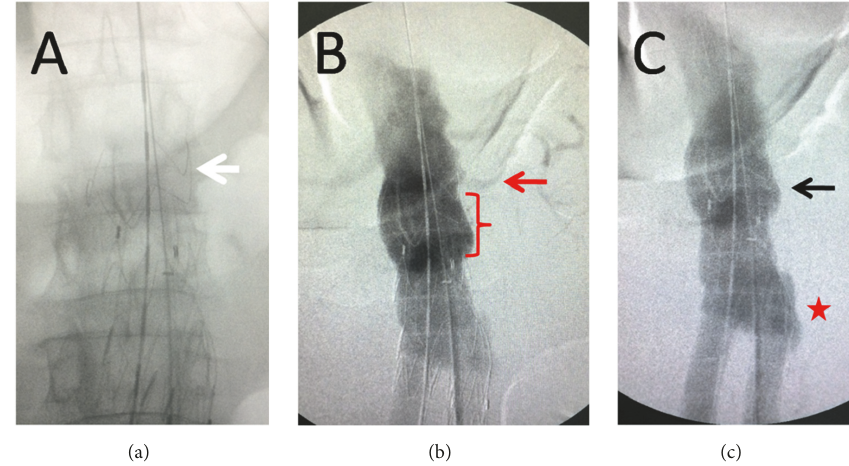
Figure 2: Initial intraoperative angiography. The Talent suprarenal crown was found to be damaged ((a), white arrow), the endograft was migrated 2 cm distally to the left renal artery ((b), red arrow and red bracket), and the proximal sealing was lost and a type Ia endoleak was shown ((c) black arrow). At the moment the second endoleak ((c), red star) pool was advocated as a continuation from the Ia